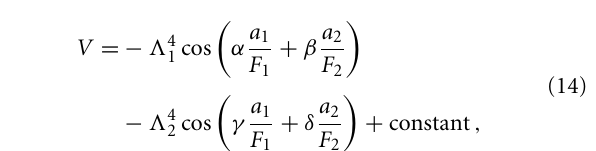
FIGURE 5 | The chaotic inflation with m 2 φ 2 [151]. The red bullet is the Lyth bound which is far above M P